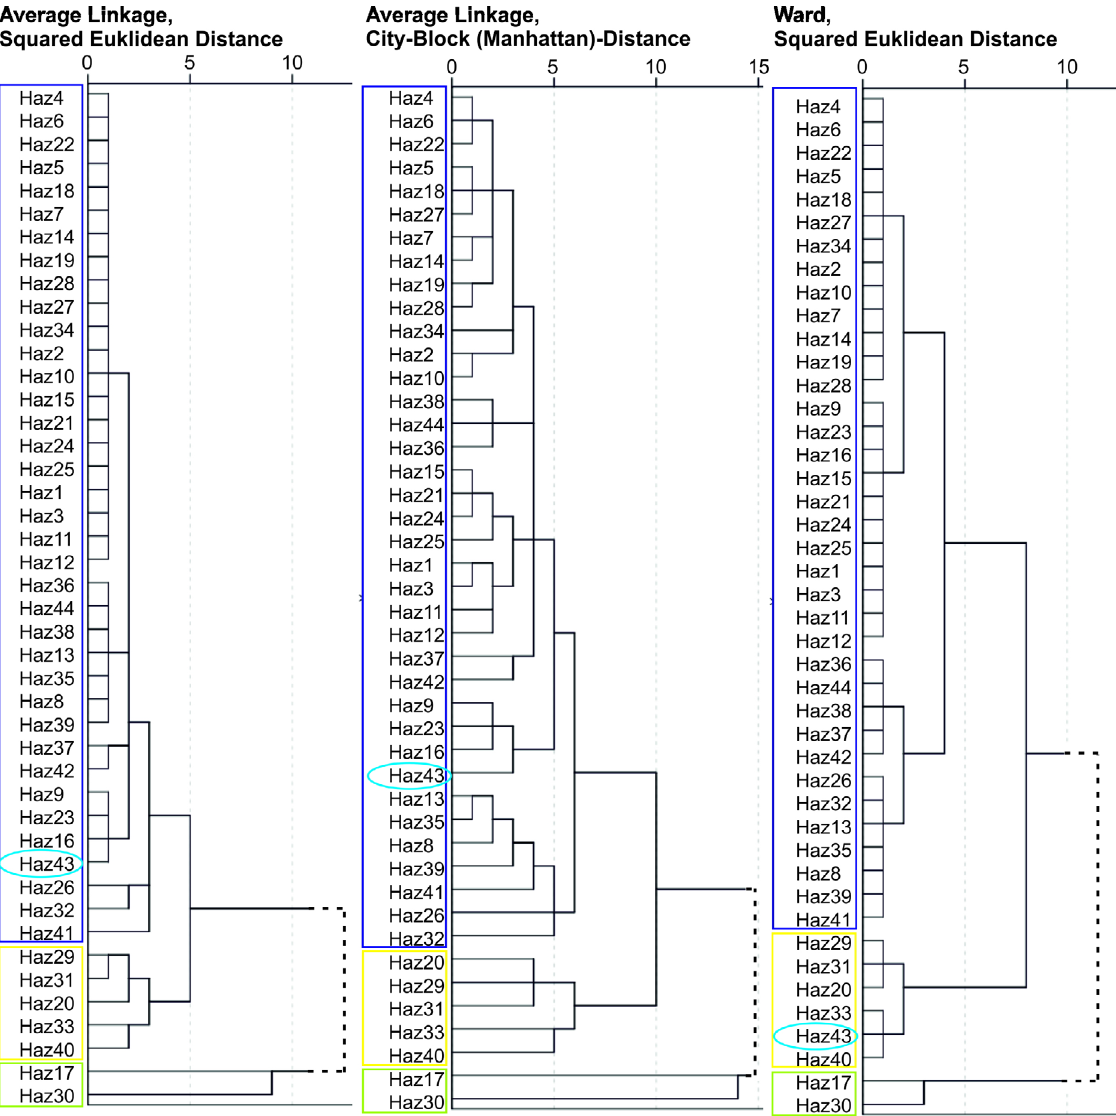
Figure 6. Cluster analysis results. The Tel Hazor reference group is marked with a blue frame and the vessels representing a potential second extraction site are marked with a yellow frame. The two individuals are marked in green. Haz43 is marked with a light blue